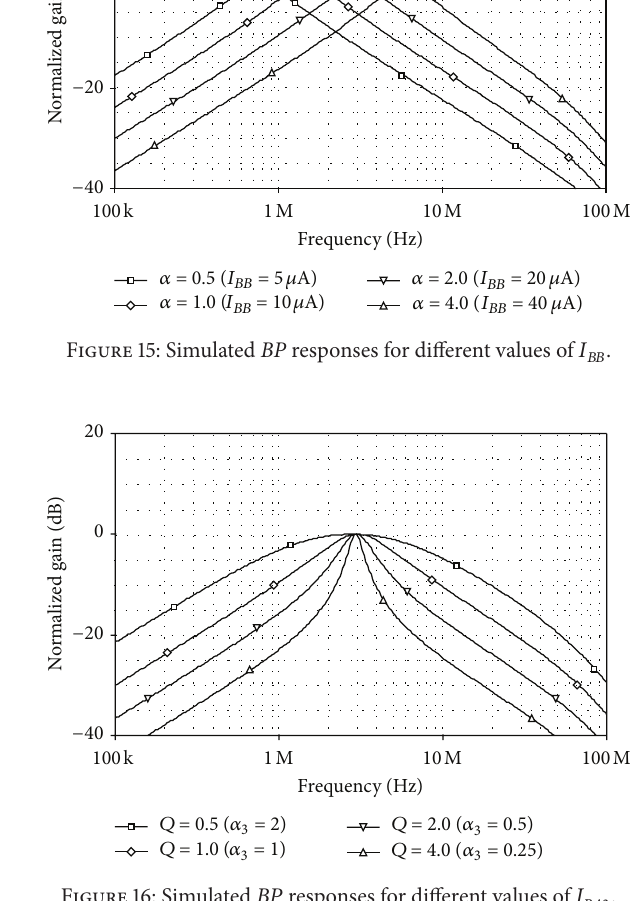
Figure 16: Simulated 𝐵𝑃 responses for different values of 𝐼 𝐵𝐴3